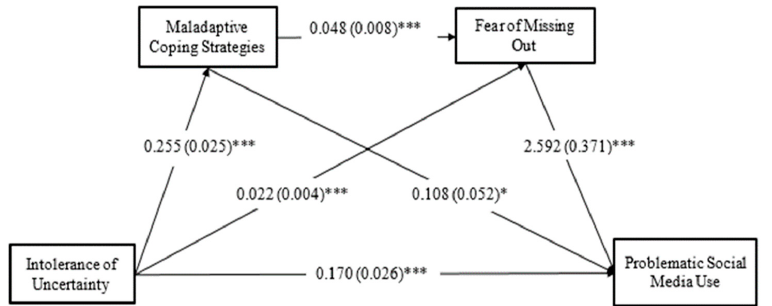
Figure 1. Serial mediation of the relation between intolerance of uncertainty and problematic social media use by the maladaptive coping strategies and fear of missing out. Age and gender were controlled during the data analysis but are not presented for reasons of simplicity. *** p < 0.001, ** p < 0.01, * p < 0.05. Table 3. Bias-corrected bootstrap test in mediating effect when maladaptive coping strategies and fear of missing out were entered as the mediation variables (n = 311).